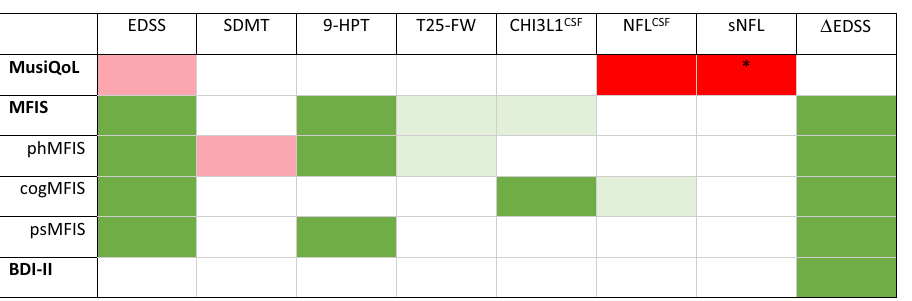
Table 3. Correlation of baseline PRO with clinical variables and biomarkers. Legend of colors: “red” shows negative correlation; “green” shows positive correlation; “light red” or “light green” shows tendency ( P < 0.1) for negative or positive correlation, respectively. Abbreviations: MusiQoL: Multiple Sclerosis Quality of Life; MFIS: Modified Fatigue Impact Scale; phMFIS: MFIS physical; cogMFIS: MFIS cognitive; psMFIS: MFIS psychosocial; BDI-II: Beck Depression Inventory-II; EDSS: Expanded Disability Status Scale; SDMT: Symbol Digit Modality Test; 9-HPTd: 9-Hole Peg Test dominant hand; 9-HPTd: 9-Hole Peg Test non-dominant hand; T25-FW: Timed 25-Foot Walk Test; CHI3L1: chitinase3 like-1; NFL: neurofilament light chain protein; CSF: cerebrospinal fluid; sNFL: serum NFL; ∆EDSS: EDSS change. (*)Disease